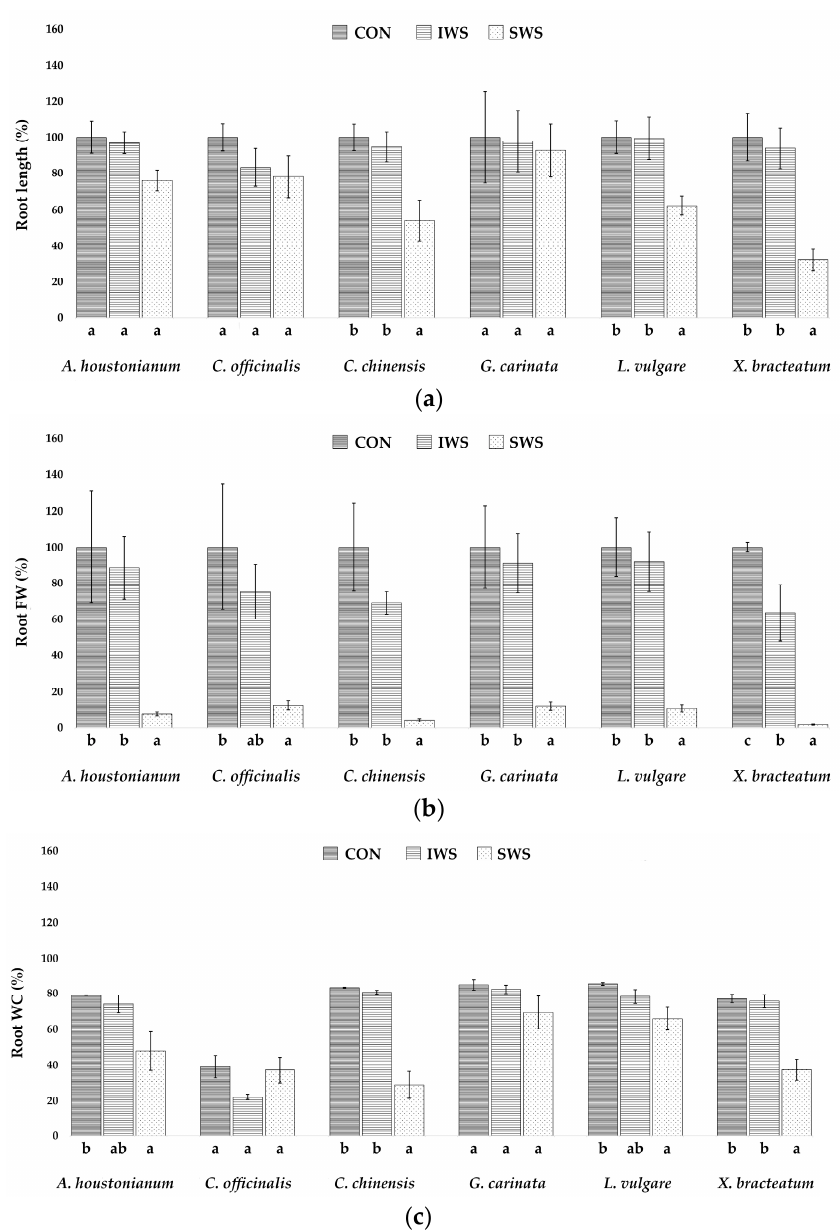
Figure 3. Effect of water stress on the root length ( a ), fresh weight (FW) ( b ) and water content (WC) ( c ) in the six Asteraceae species. Bars indicate mean values with SE ( n = 5) of percentage relative to the control averages for each species, shown in Table 1. Different lowercase letters indicate significant differences between treatments (CON—control, IWS—intermediate water stress, and SWS—severe water stress) per species, according to the Tukey test ( p < 0.05).